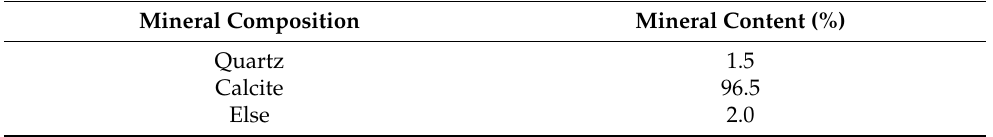
Table 1. XRD analyses of carbonate rocks.